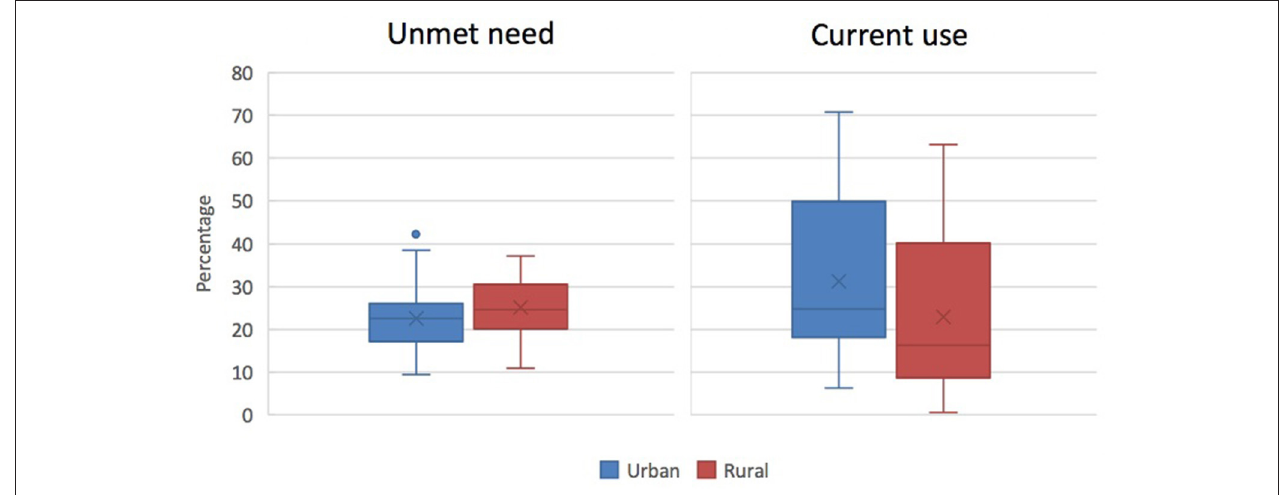
FIGURE 3 | Percentage of currently married or in-union women with an unmet need for FP (left) or currently using any modern method of contraception (right) in sub-Saharan Africa, according to place of residence (source: ICF, 2015. The DHS Programme STATcompiler. http://www.statcompiler.com. Accessed May 27